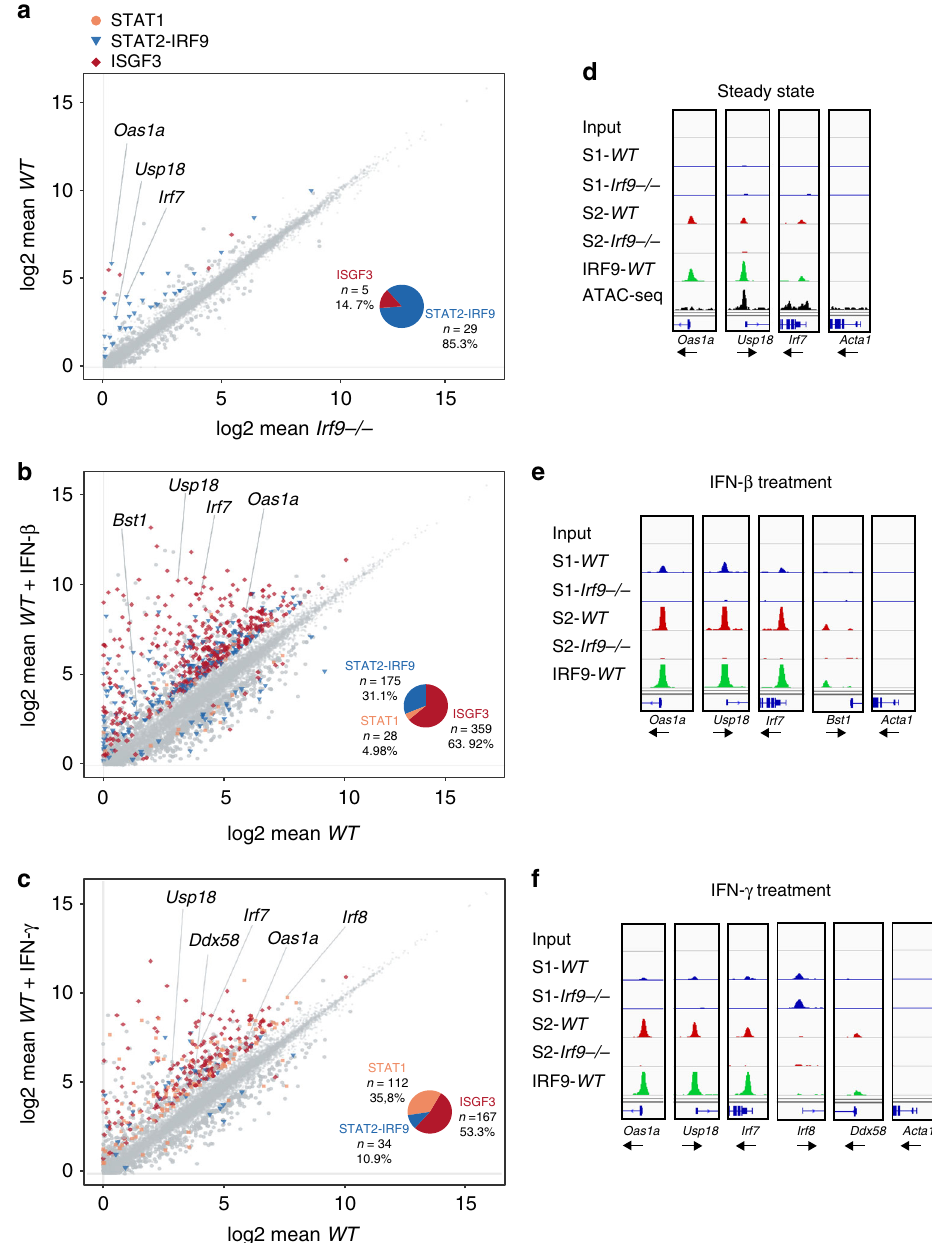
Fig. 2 IFN-induced gene expression and STAT complexes in BMDM. a – c panels on the left. Scatterplot linking RNA-seq ( n = 3) with ChIP-seq ( n = 2) data (BMDM). Differentially expressed genes (log-fold change (lfc) > 1, padj < 0.05) between Irf9 − / − and WT untreated ( a ), WT untreated versus WT IFN- β ( b ), or WT untreated versus IFN- γ -treated ( c ) BMDM are shown. Genes associated with complexes containing at least one of the ISGF3 subunits (STAT1, STAT2, and IRF9) according to ChIP with the respective antibodies are color-coded as follows. Blue triangles: STAT2 – IRF9; red diamonds: STAT1, STAT2, and IRF9 (ISGF3); beige squares: STAT1 only. The pie chart inserts show the relative proportions of genes associated with STAT2 – IRF9, ISGF3, or STAT1 dimers. Panels on the right d – f . Representative browser tracks of the ChIP-seq experiments shown in a – c ). Data from untreated ( d ), IFN- β (90 min; e ), or IFN- γ - (90 min; f ) treated BMDM derived from wild-type (WT) and Irf9 − / − ( IRF9 − / − ) mice are shown (scale 0 – 150). Individual tracks represent binding of STAT1 (S1/blue), STAT2 (S2/red), and IRF9 (green). Tracks are shown for ChIP-seq and control input, as well as regulatory chromatin sites from ATAC- seq for untreated BMDM, derived from data in ref. convincingly demonstrate constitutive binding of any of the ISGF3 subunits (Supplementary Fig. 4e). Possible causes for this result are considered in the “ Discussion ” section.